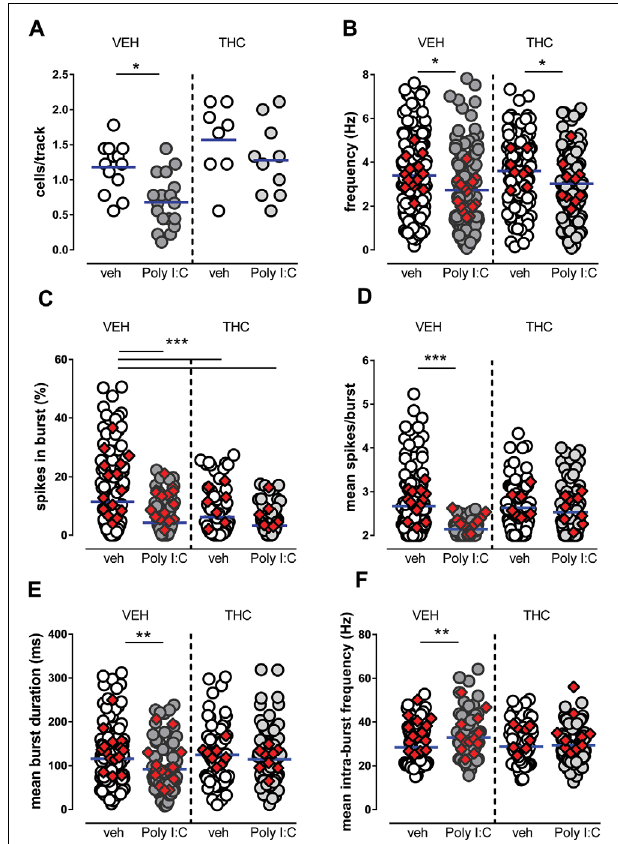
FIGURE 1 | Effects of maternal immune activation (MIA) and adolescent ∆ 9 -tetrahydrocannabinol (THC) administration on ventral tegmental area (VTA) dopamine neuron activity in vivo . Adolescent THC administration prevented the Poly I:C-induced decrease in the number of spontaneously active VTA dopamine neurons (A) but not the decrease in firing rate (B) . Graphs show the effect of poly IC and THC (or vehicles) in the percentage of spikes in burst (C) , mean burst duration (D) , mean number of spikes in bursts (E) and intra-burst frequency (F) . Superimposed colored diamonds show the averages for each individual rat. Both Poly I:C and THC, or their combination, induced a reduction in the percentage of spikes in bursts (C) , whereas THC prevented alterations induced by Poly I:C in the other electrophysiological parameters (D,E) . The number of cells for each group is: veh-veh, n = 156; Poly I:C-veh, n = 121; veh-THC, n = 101; Poly I:C-THC, n = 117. The horizontal blue line represents the mean. Statistical analysis was conducted with two-way ANOVA (Poly I:C and THC treatments as factors) and Sidak’s multiple comparison test. Asterisks on graphs represent the result of